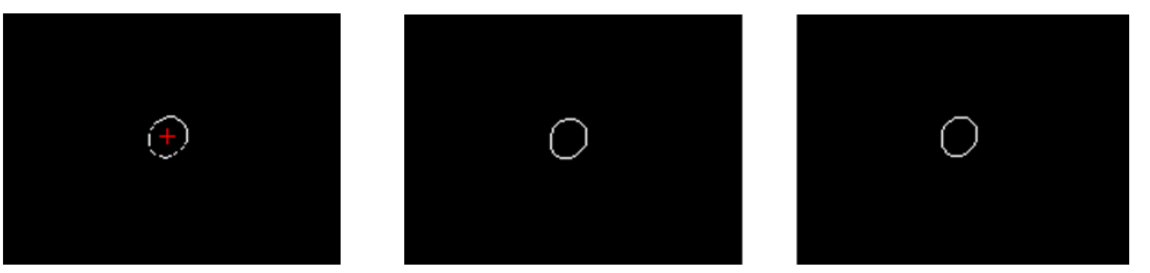
Fig. 4 Process of detecting